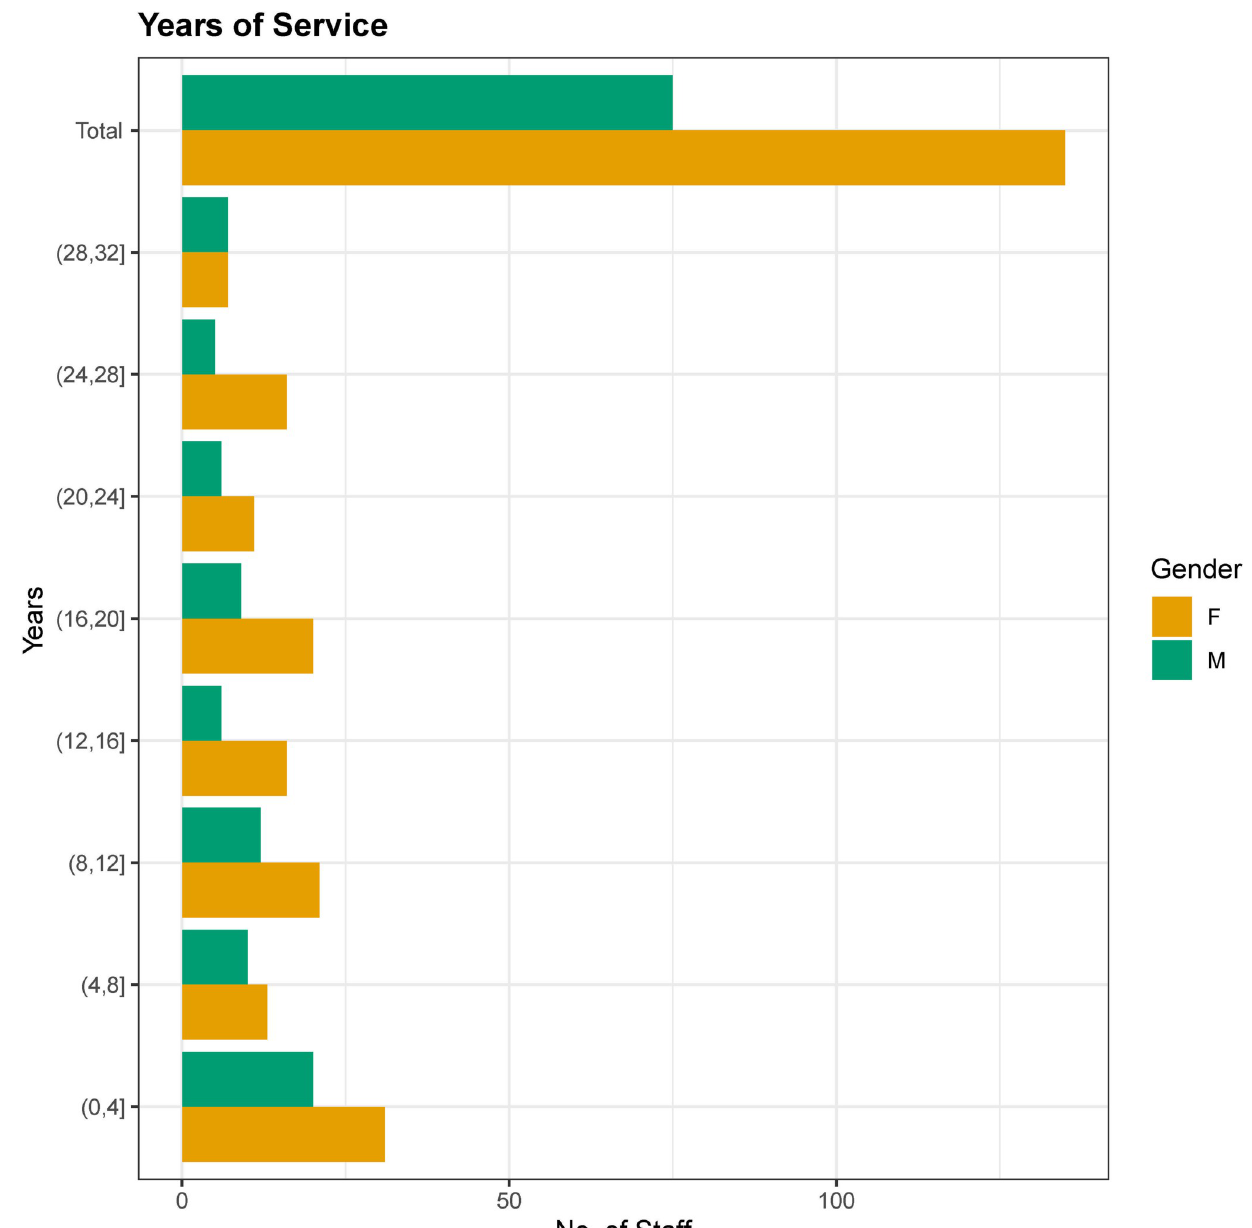
Fig 3. Comparison of years of service between males & females. Histograms of recruited employees per 4-year